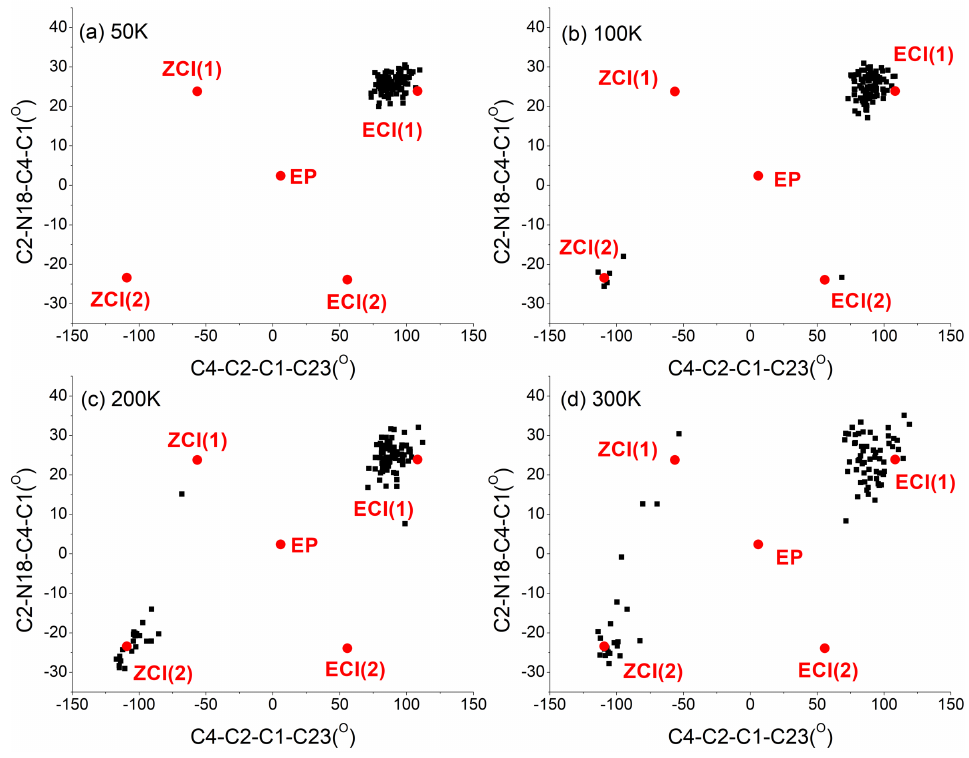
Figure 5. Distribution of the C4-C2-C1-C23 and C2-N18-C4-C1 dihedral angles at the hopping events of successful EP → ZP photoisomerization trajectories starting from the EP structure of DDPY at ( a ) 50 K, ( b ) 100 K, ( c ) 200 K, and ( d ) 300 K, respectively. The corresponding points of ground state EP isomer, S 1 /S 0 conical intersections E CI(1), E CI(2), Z CI(1), and Z CI(2) are also presented in the